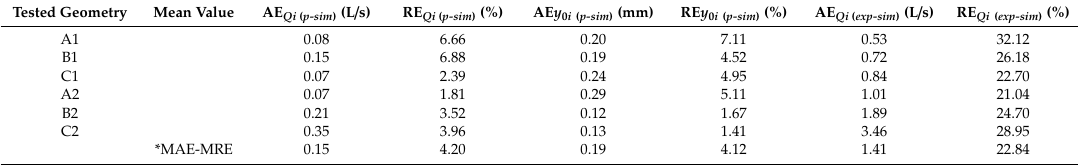
Table 9. AE: Absolute Error and RE: Relative Error.